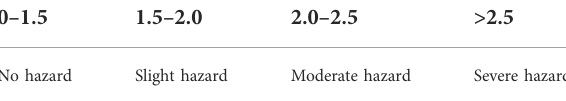
TABLE 4 Classi fi cation of rock burst danger